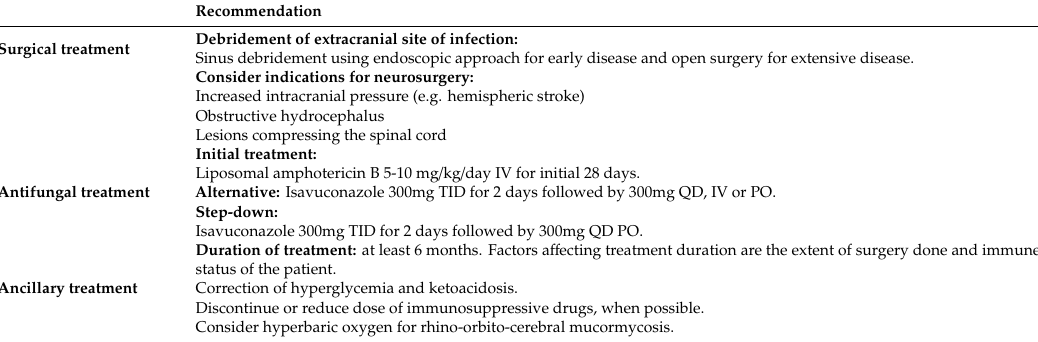
Table 2. Recommendations for treatment of central nervous system